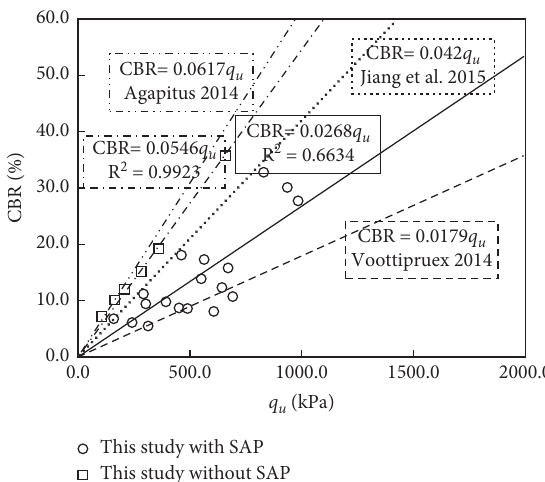
Figure 5: Correlation of the CBR with q